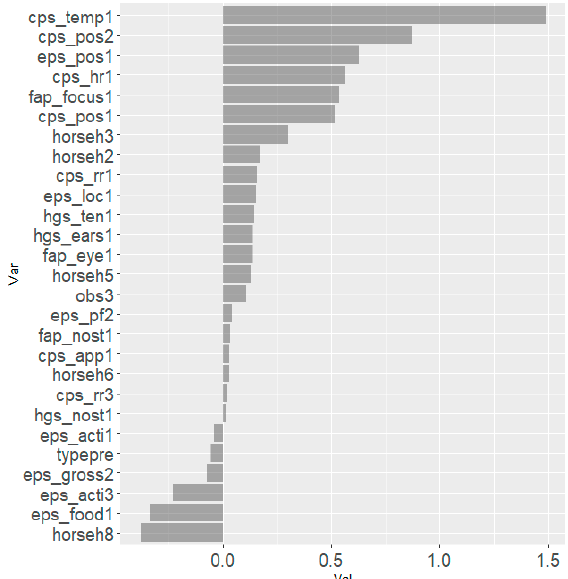
Figure 6. Coefficient of Lasso regression models with lambdas generating the minimum mean cross-validated error when using scale items of all scales to predict movement asymmetry. Scale items from the four equine pain scales (Horse Grimace Scale (HGS), Equine Utrecht University Scale of Facial Assessment of Pain (EQUUS-FAP), Equine Pain Scale (EPS) and Composite Pain Scale (CPS)) were analyzed in the same model.